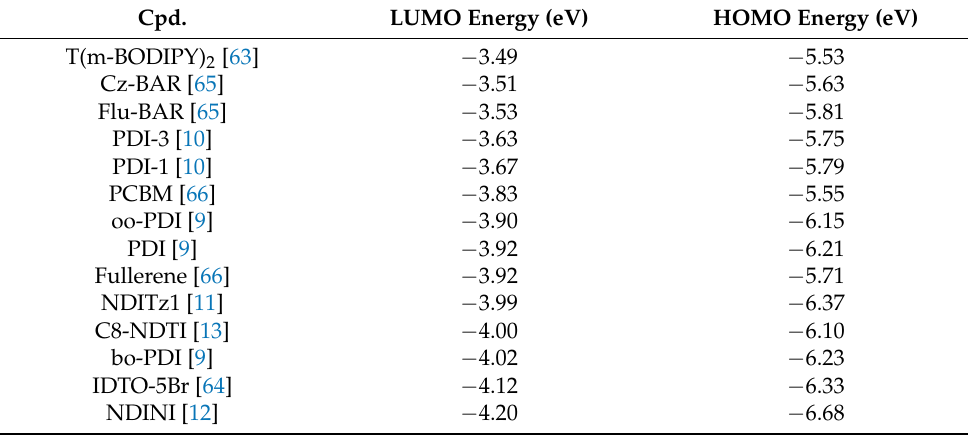
Table 3. HOMO and LUMO energy values of various n-type organic semiconductors estimated Table 2. Onset reduction potential (E’ red ), LUMO energies, and HOMO data obtained. under similar conditions